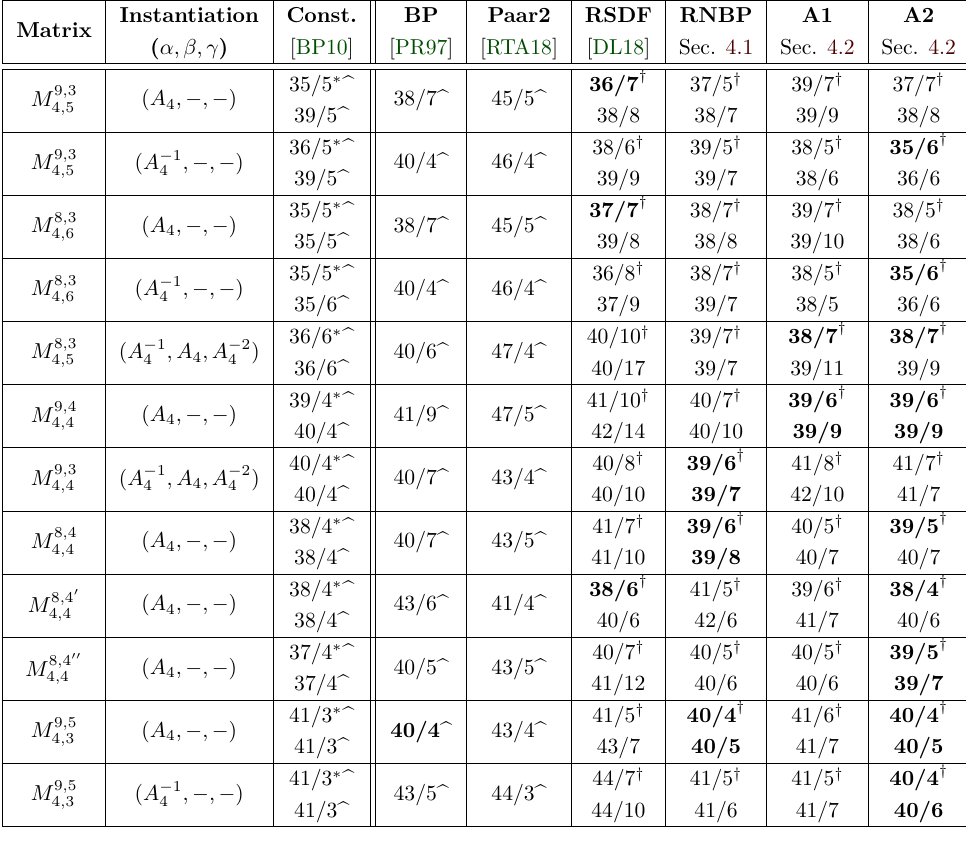
Table 6: Circuit cost (XOR/Depth) of matrices of size 16 × 16 from [DL18] using several optimisation